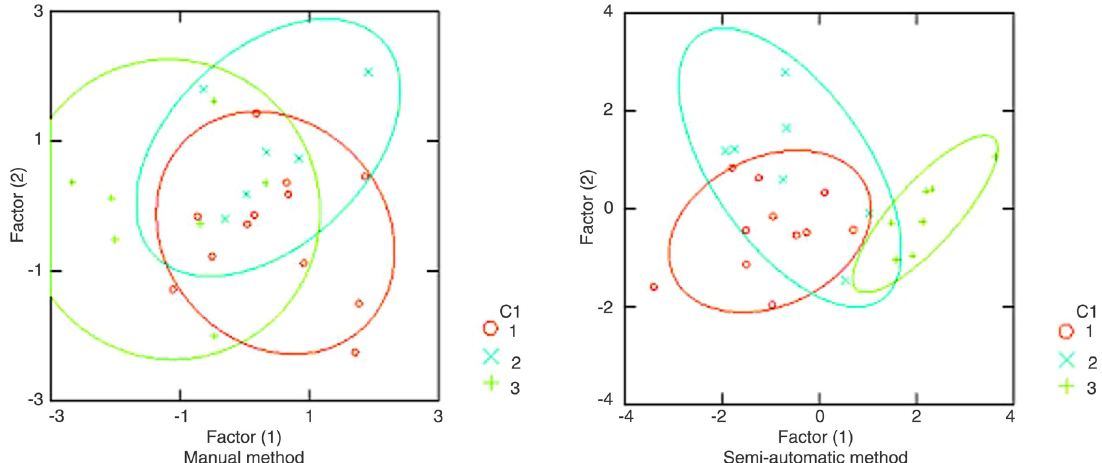
Figure 4. Discriminant distributions of tumor groups for the manual (left) and semi-automatic (right) methods. Red corre- sponds to high-grade neuroglial tumors (group 1), blue to non-neuroglial tumors (group 2) and green to pilocytic astrocy- tomas (group 3).